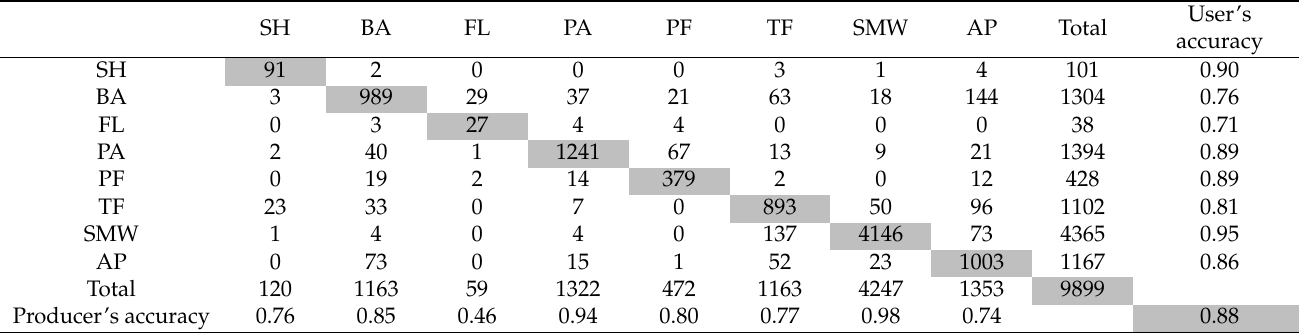
Figure 3. The thematic map output in 2018. The embankment or coastal dam is evident in the 2018 image, along with other new features. Table 1. The accuracy assessment of classification. SH: seepweed; BA: built-up area; FL: forest land; PA: reed field;